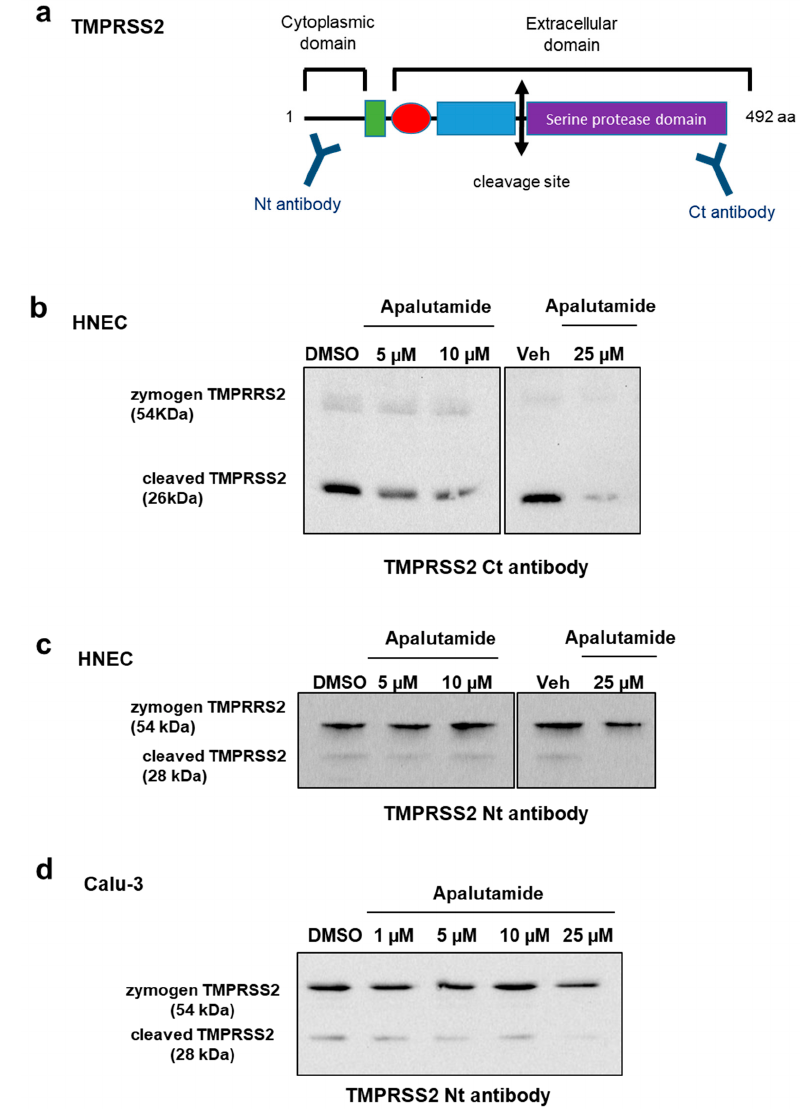
Figure 6. Effect of apalutamide treatment on TMPRSS2 catalytic cleavage. ( a ) Schematic representation of TMPRSS2 structure with antibodies recognition sites; ( b – d ) Western blot analysis of TMPRSS2 in HNECs ( a , c ) or Calu-3 cells ( d ) treated with apalutamide for 48 h, using an antibody directed against the C-terminal ( b ) or the N-terminal region of TMPRSS2 ( c , d ).